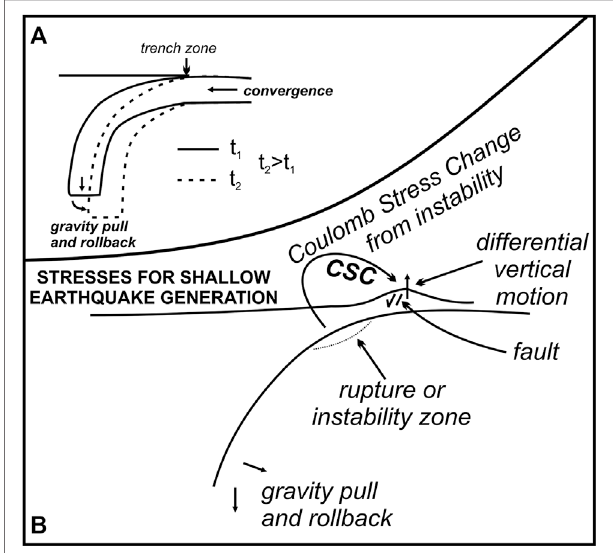
FIGURE 7 | Panel (A) reports a sketch representation of the gravity- inducedsubductionslabrollbackandplateconvergenceinsouthernCalabria. Thecontinuousanddashedlinesindicatethelocationoftherollbackingslabat different times t 1 and t 2 , with t 2 > t 1 . Rollback and convergence are oriented SE- and NNW-ward, respectively. Their almost opposite motions tend to balance each other, what causes very low horizontal strain rate at Earth ’ s surface and gradually decreasing coupling between the subducting and overriding plates. The detail of the contact zone between subducting slab and overthrusting plate shown in panel (B) furnishes a schematic view of seismogenic processes occurring at shallow depth in the overriding plate (Tyrrhenian-southern Calabria unit). In our reconstruction, instabilities of the upper part of the Ionian subducting slab (such as the 1905 major earthquake; see also Figure 2 ) and chain-to-valley differential vertical motion detected at surface would play the role of dynamic sources of normal-faulting earthquake activity occurring at shallow depth in southern Calabria. Basically, major shallow earthquakes of southern Calabria result from complex interaction between different dynamic factors (subduction slab rollback and plate convergence)and, fi nally,from vertical dynamicsproduced